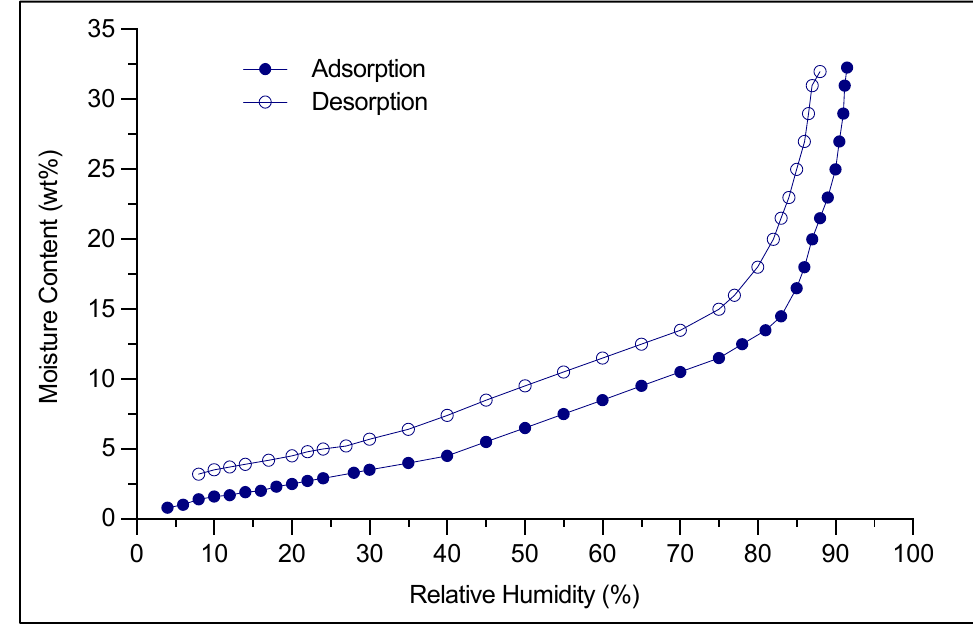
Figure 3. Water vapor adsorption and desorption isotherm curve obtained at 25 ◦ C by Quali-V-I Extra Dry capsules (Qualicaps ® , Tokyo, Japan). These data are obtained by means of a volumetric method as per USP41<1241> (Adapted from Ref. [33]). CC BY 4.0 license. All data were obtained from [33], https://ondrugdelivery.com/quali- v-extra-dry-a-novel-capsule-for-delivering-hygroscopic-pharmaceutical-drugs, accessed date: 5 October